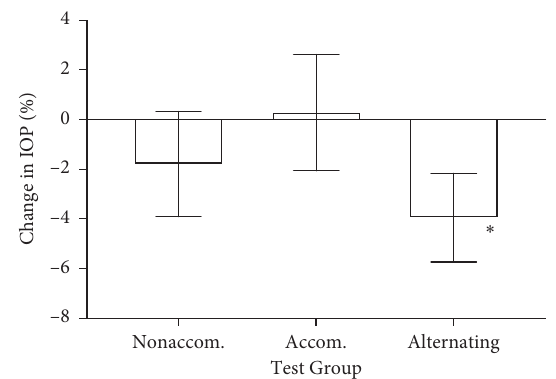
Figure 2: Percent change in IOP from pretest, right eye. Non- accom, focusing without accommodation on target for 10 minutes; Accom, focusing on target through − 3 diopter lens for 10 minutes; Alternating, alternating between nonaccommodation and ac- commodating conditions every minute for 10 minutes. Asterisk indicates p < 0.05 when compared to baseline, paired t -test. Error bars indicate standard